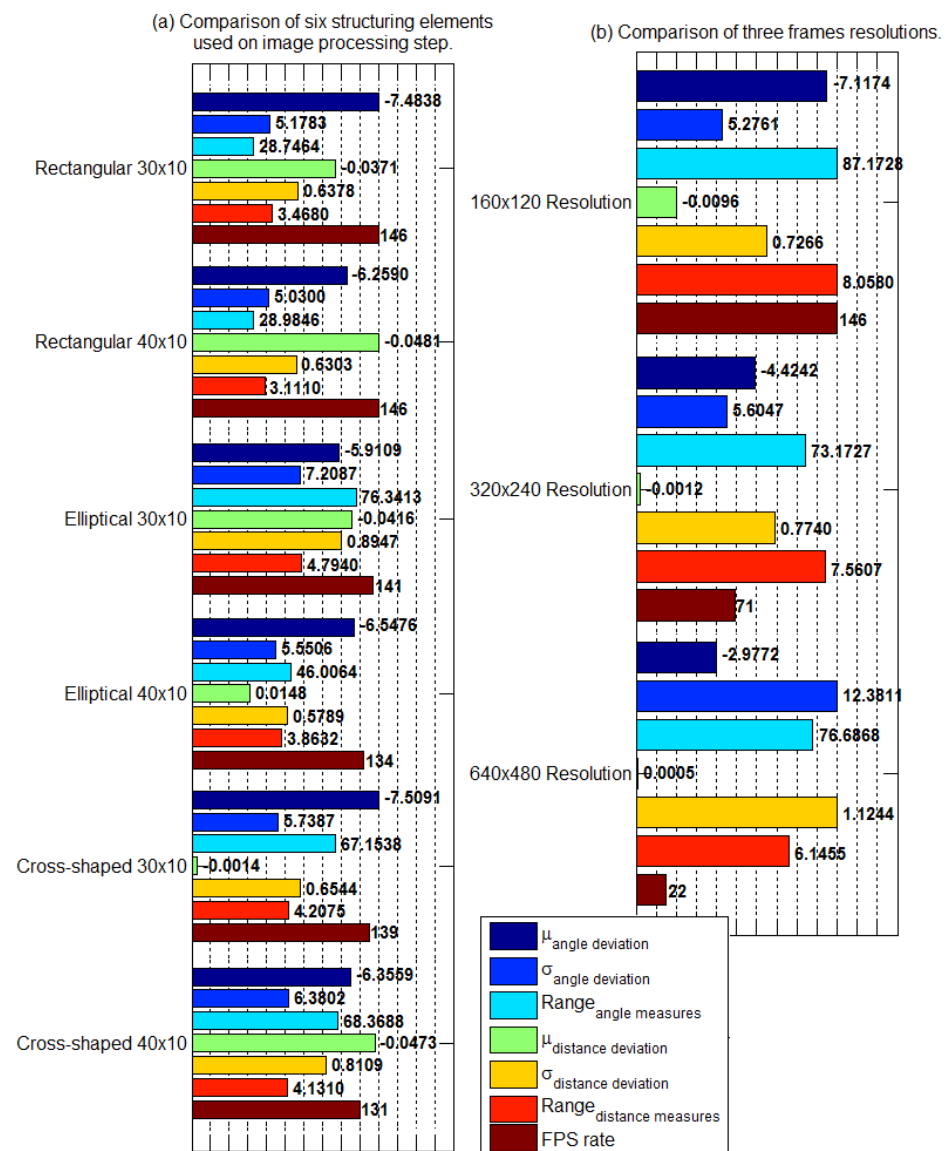
Figure 31. Trials results comparison. ( a ) structuring element, or kernel, variation; ( b ) frame resolution